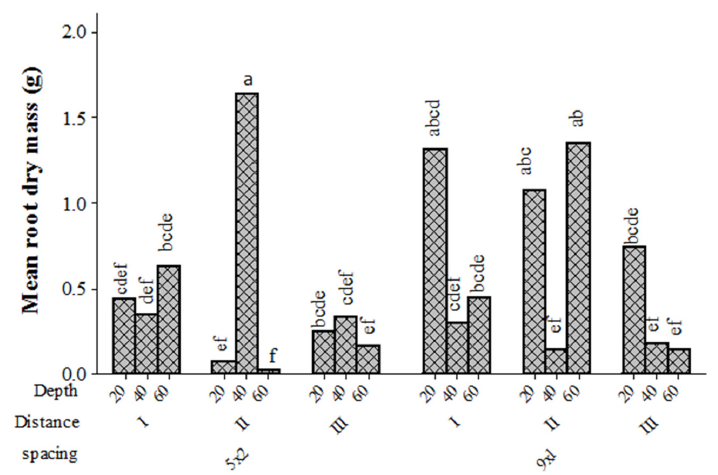
Figure 6. Mean root dry mass (g) of E. camaldulensis in relation to spacing (5 m × 2 m versus 9 m × 1m), distance from the tree, and soil depth for stands established in 2007 with rice intercropping. Bars with the same letter (s) are not significantly different at 5% probability.